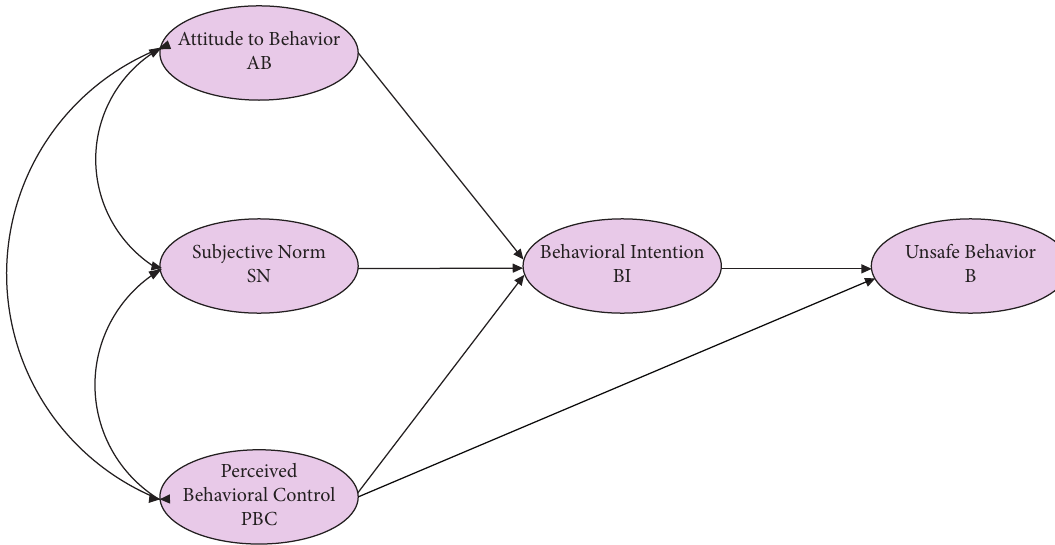
Figure 1: Conceptual model of road-crossing violations among young pedestrians based on the